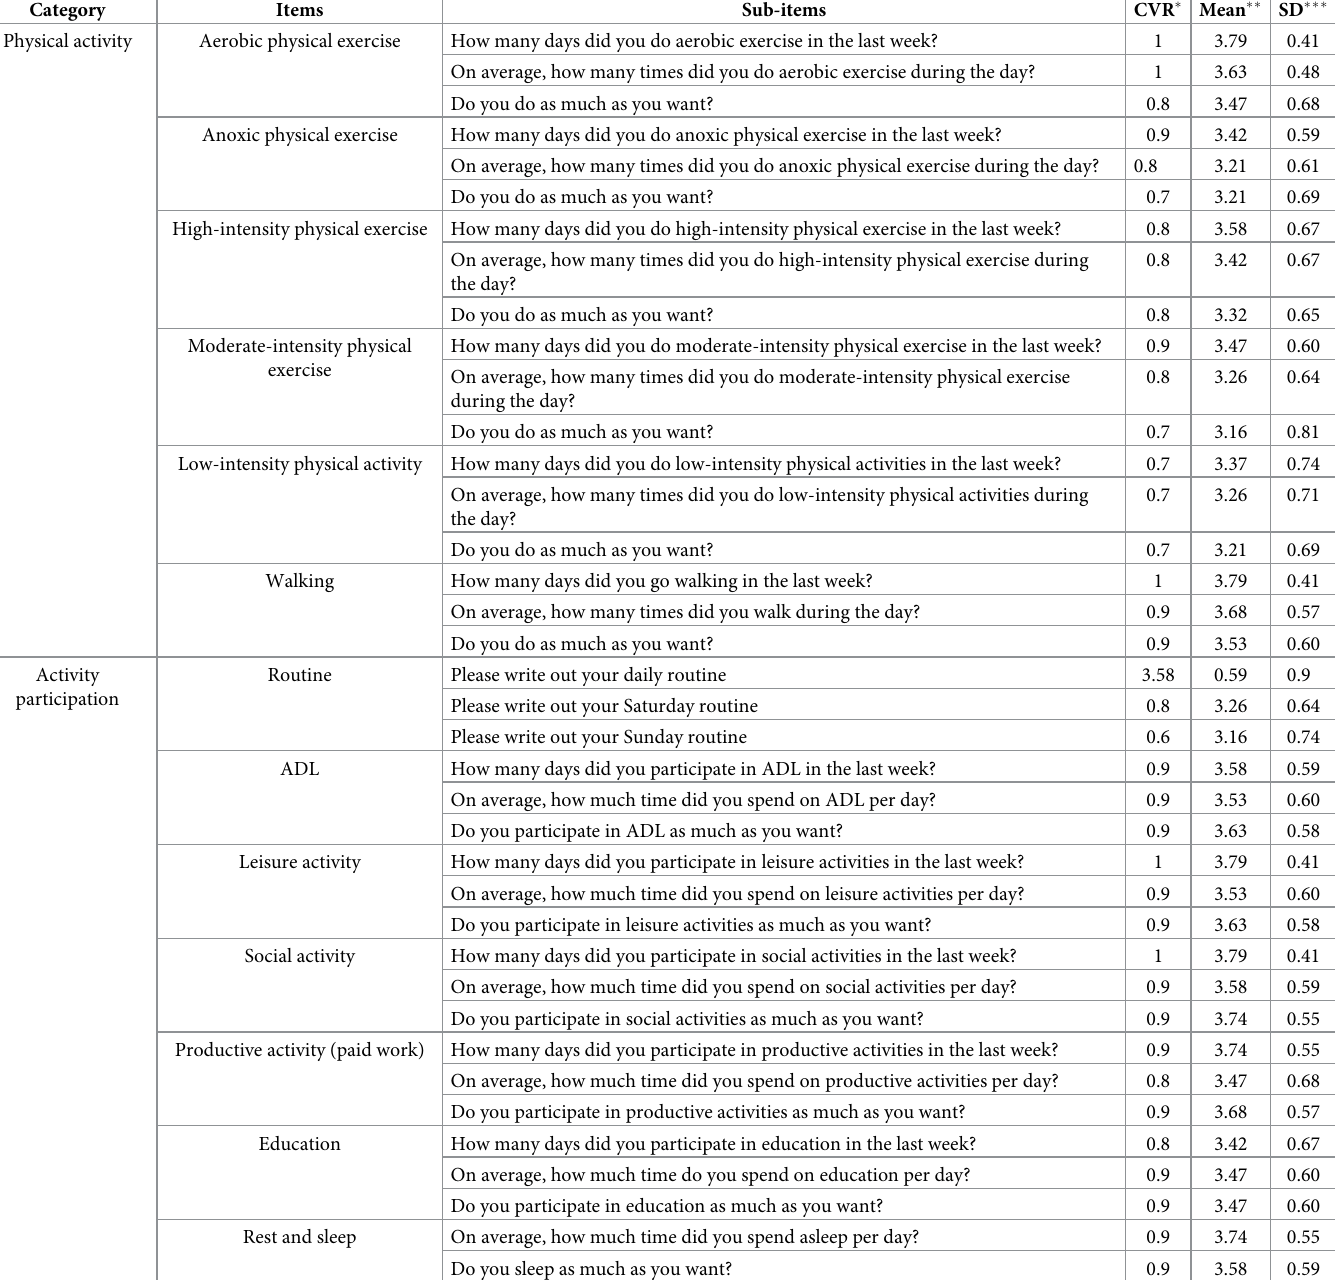
Table 5. Contents of the multifaceted lifestyle in elderly profile in the round 3 survey.